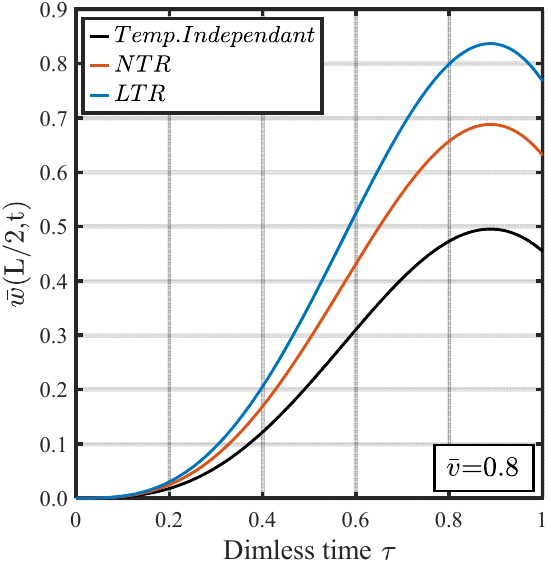
Figure 8. Influence of temperature distribution (temperature-independent, LTR and NTR with α T = 2) on the dimensionless central deflection vs. time under a uniform moving load ( k x = k z = 0.2) at v = 0.1, 0.4, and 0.8 and ∆ T = 100.